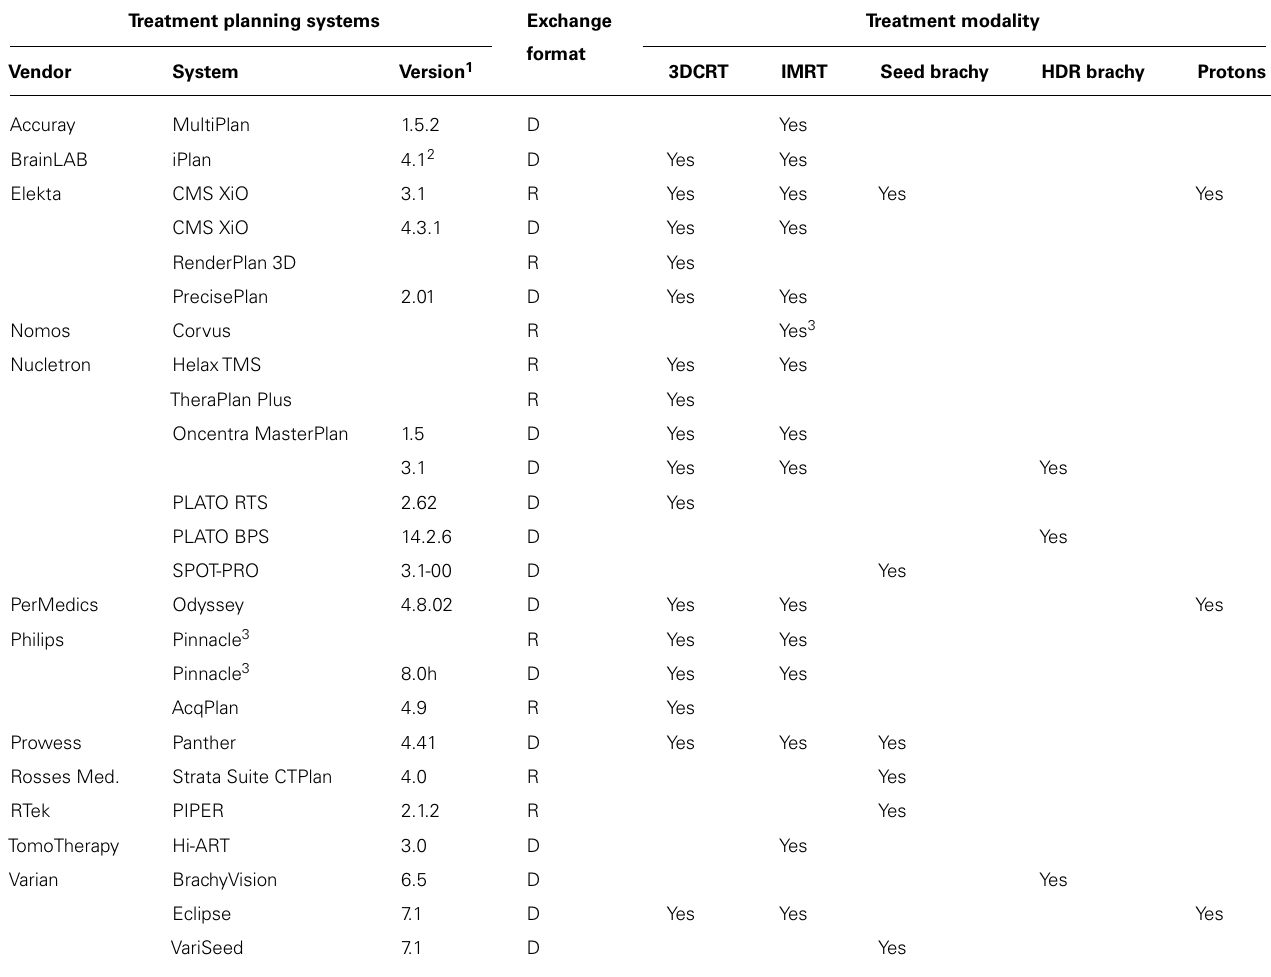
Table 2 |Treatment planning systems with the capability to transfer data electronically to the